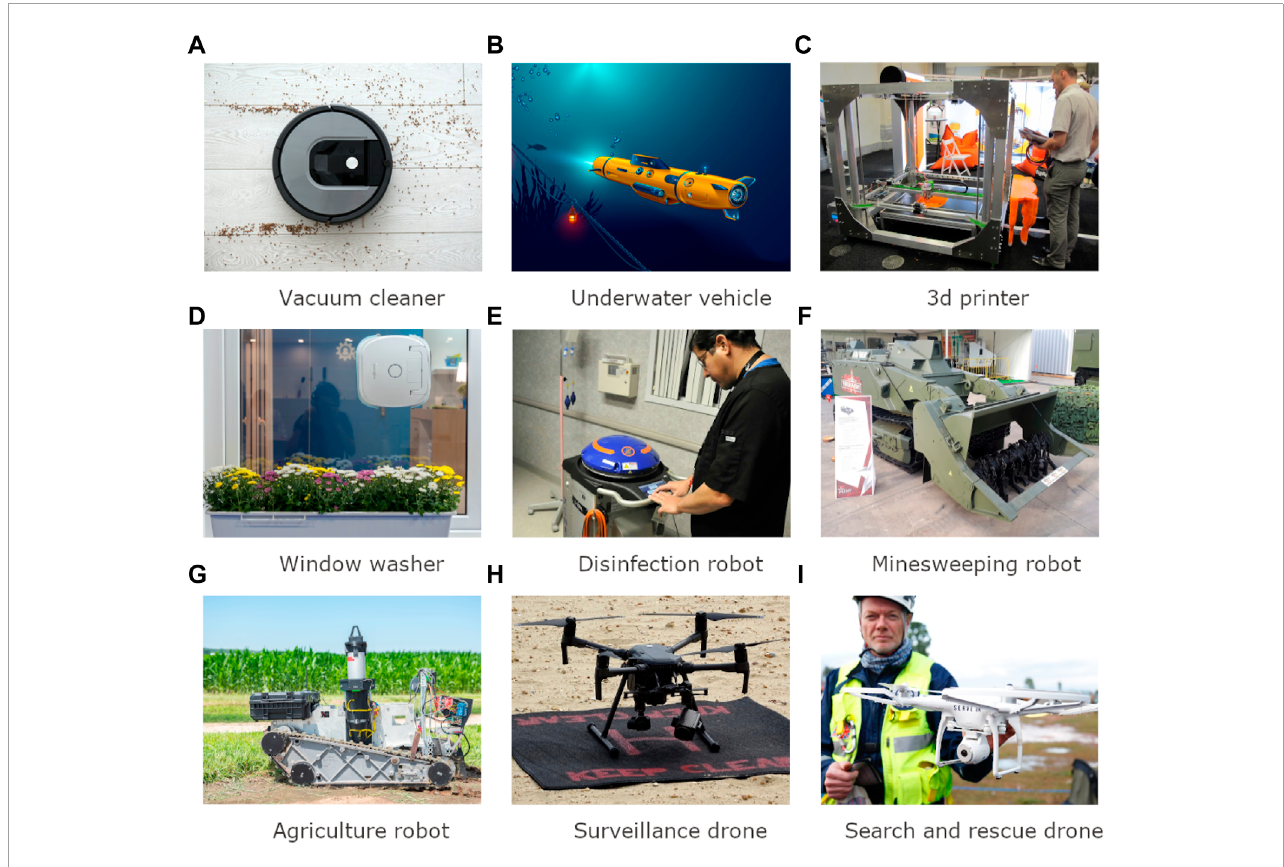
FIGURE 1 Visual representation of CPP practical applications (all photos were taken from the public